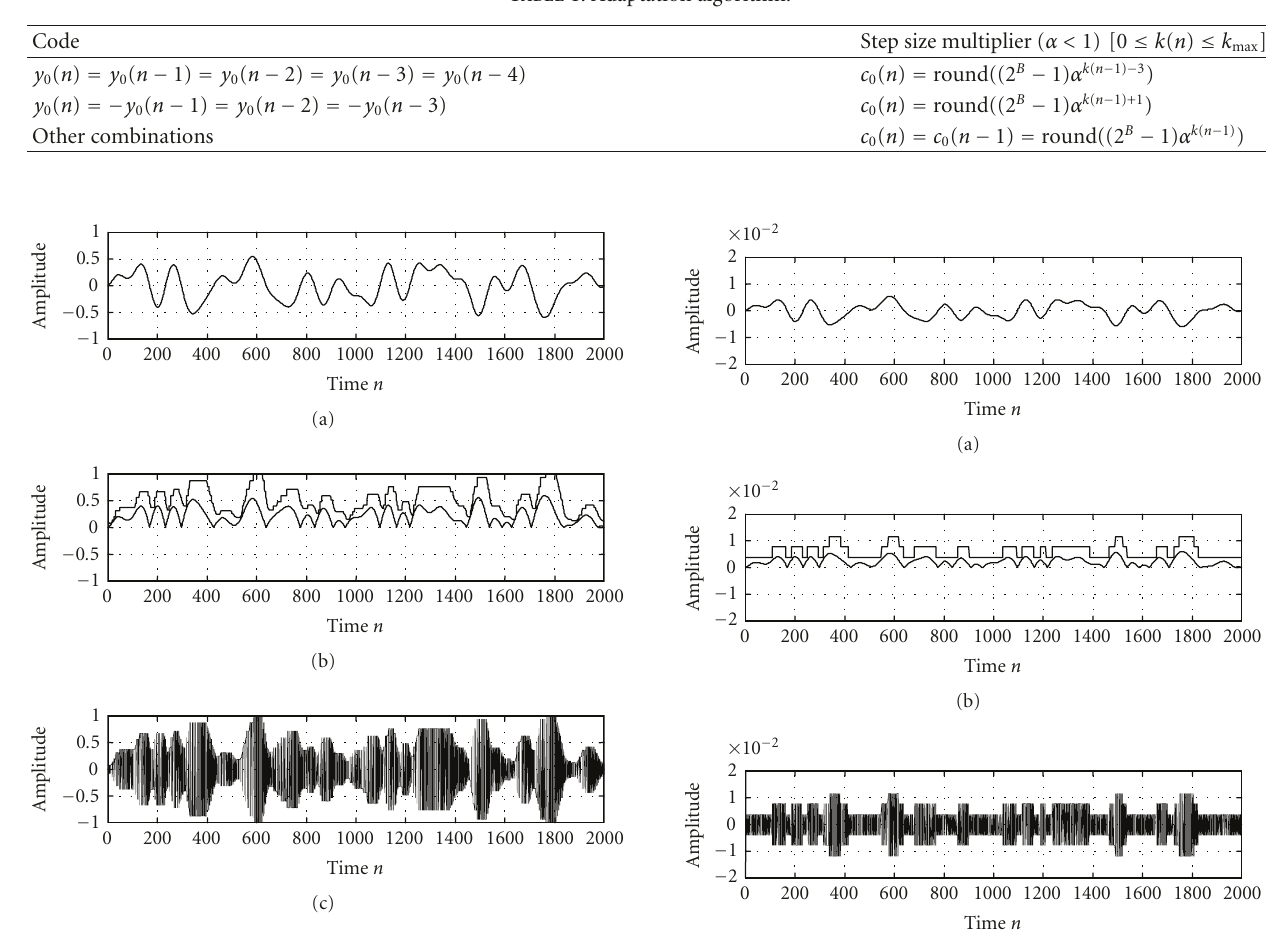
Figure 3: Example waveforms derived from an adaptive ΔΣ M modulator of first order. First trace: input signal x ( n ). Second trace: rectified input signal | x ( n ) | and feedback amplitude c ( n ) (note: c ( n ) > | x ( n ) | ). Third trace: output signal z ( n ).